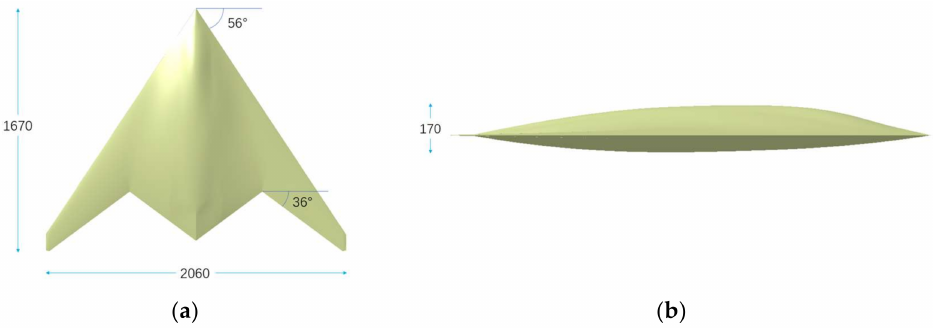
Figure 2. Geometry of a stealth aircraft. ( a ) Vertical view, ( b ) Side view.